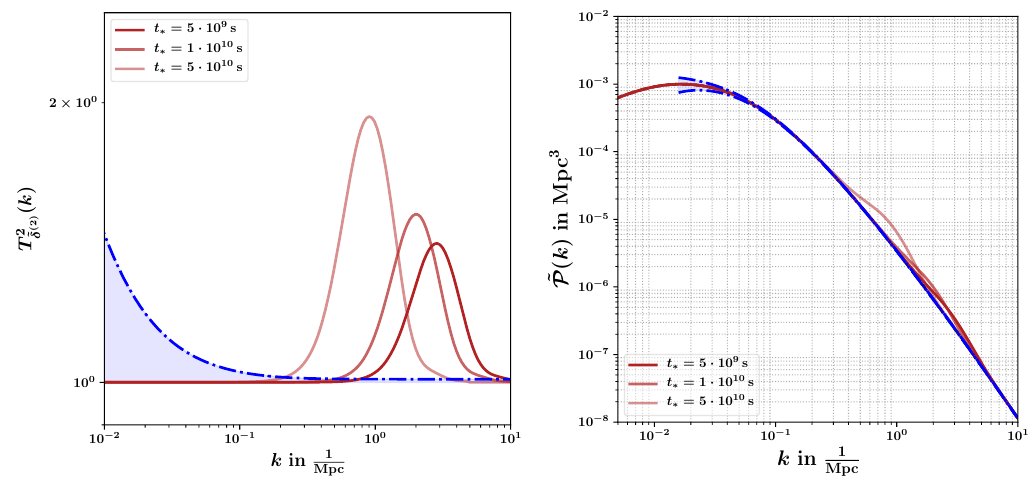
Figure 9: The impact of a late phase transition for different starting times t ∗ on the linear matter power spectrum. We chose for each time an inverse duration of β = 3 H ∗ and latent heat α = 3,